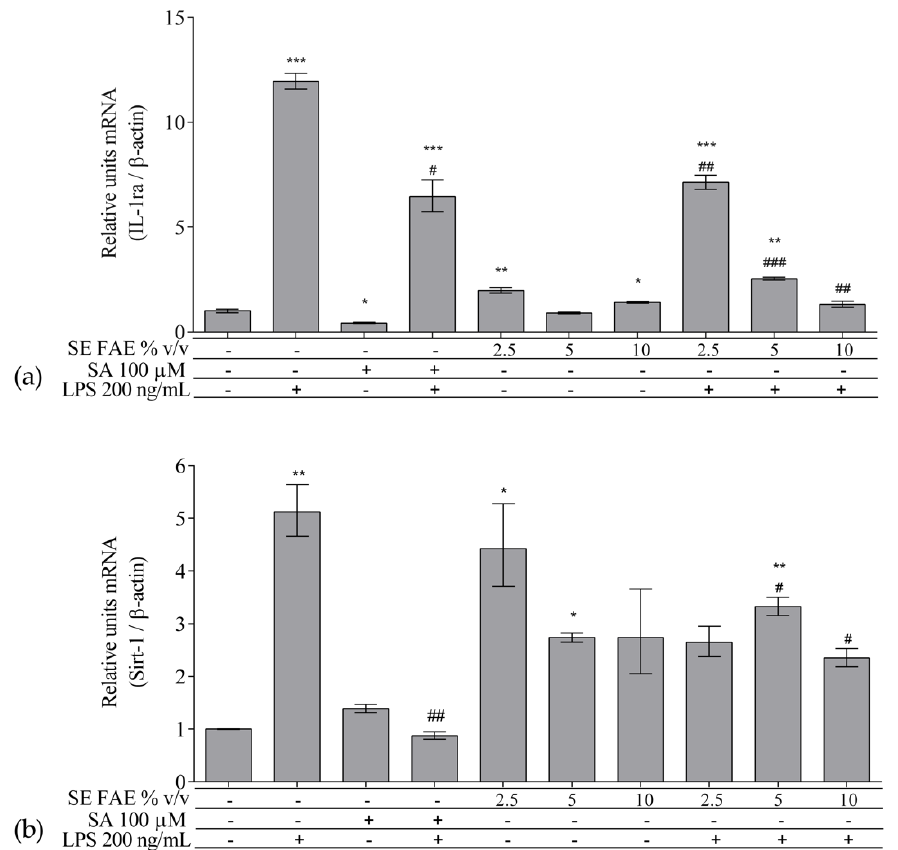
Figure 4. Changes in mRNA levels of IL-1ra ( a ) and of Sirt-1 ( b ) in J774A.1 mouse macrophages pre-treated with increasing concentrations (2.5%, 5%, 10% v / v ) of SE FAE or with SA for 24 h and subsequently stimulated or not with LPS. Results were obtained using qPCR technique. Data are presented as mean ± SEM. Legend: SE FAE– Sambucus ebulus L. fruit aqueous extract; SA–100 µ M salicylic acid; LPS–200 ng/mL lipopolysaccharides. * p < 0.05, ** p < 0.01, *** p < 0.001 vs. untreated cells; # p < 0.05, ## p < 0.01, ### p < 0.001 vs. LPS treatment.